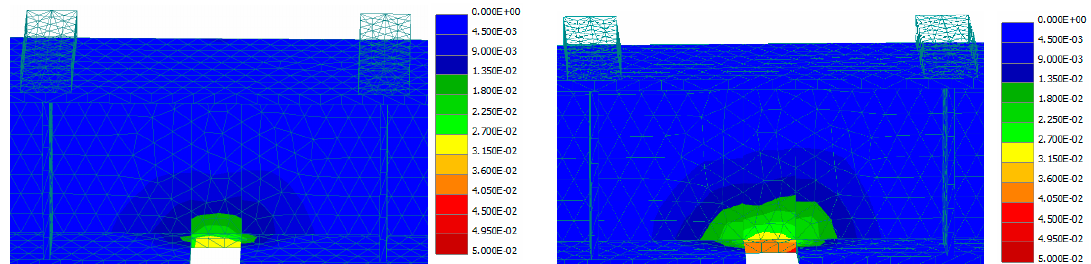
M − S, width 60mm, depth 80mm.